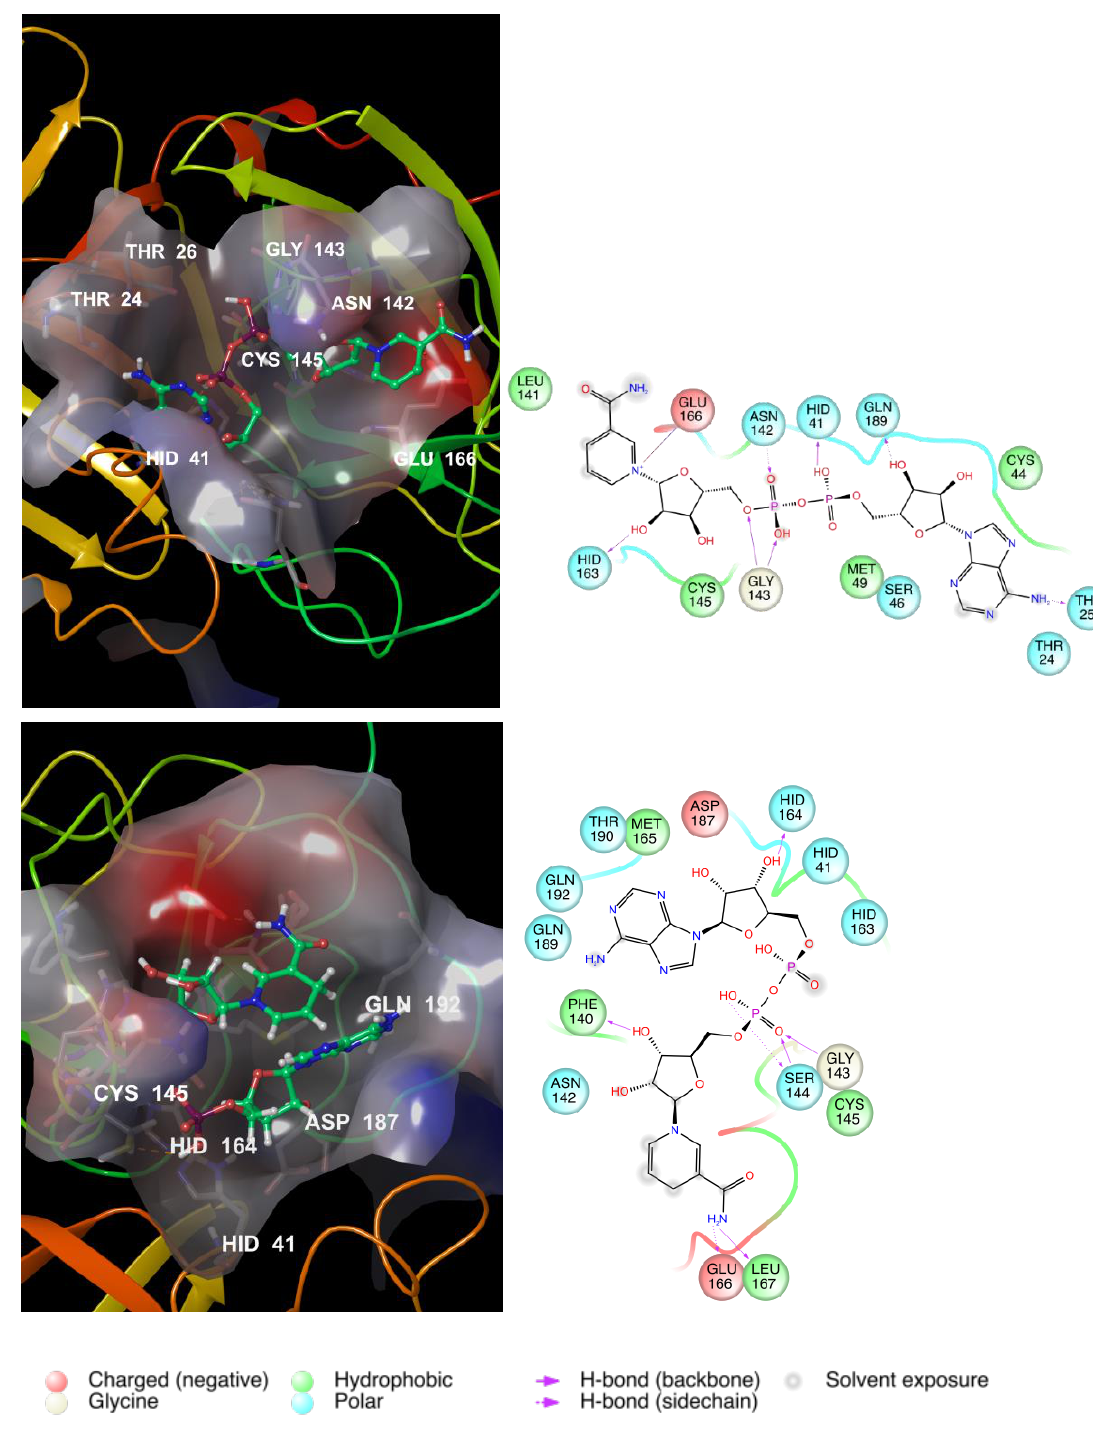
Figure 7. 3D binding modes of NAD + and NADH (left) and amino acid maps (right).